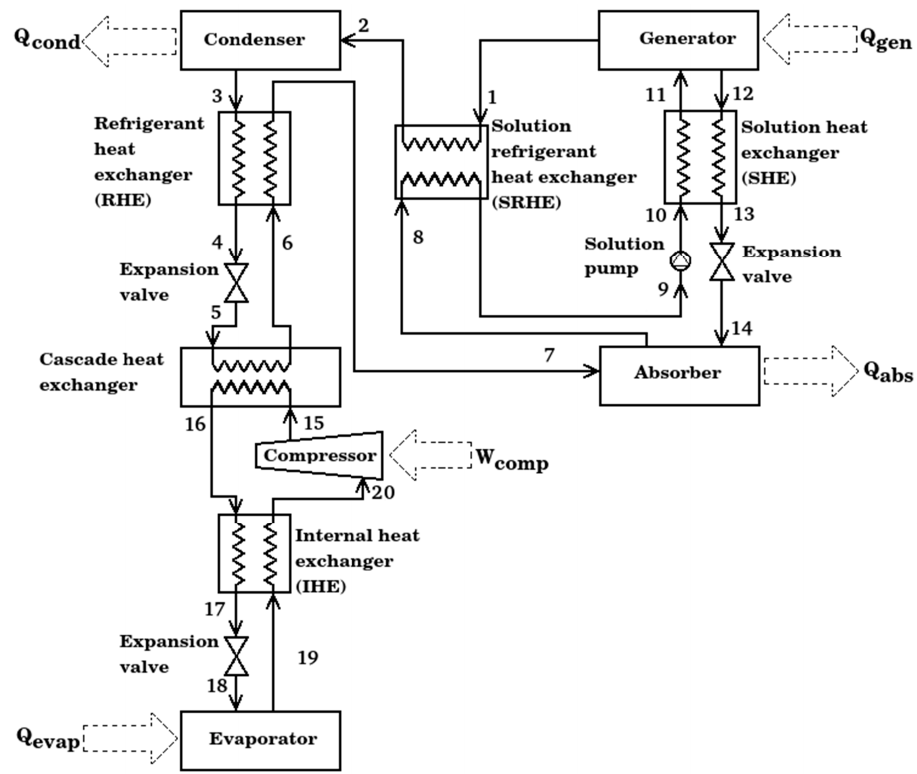
Figure 1. Schematic diagram of compression–absorption cascade system with four economizers.